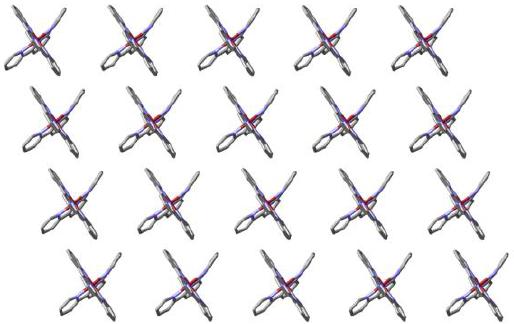
Figure 7. A partial view of a sheet of cations in the lattice of [Cu( L3 ) lying parallel to the ac plane, showing the apparent partial retention of a terpyridine embrace in the sense that terpyridine units lie in relatively close parallel planes. To emphasize this arrangement, the trimethoxyphenylmethyleneoxy substituents (as well as lattice solvent and anions) are not